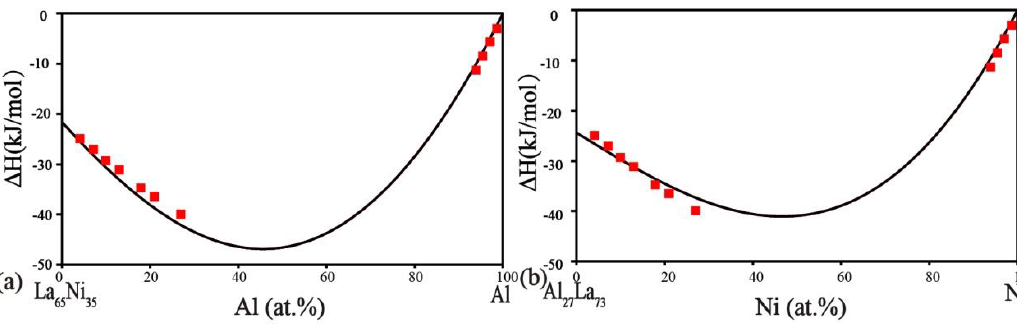
Figure 10. Calculated vertical section of Al 90 La – Al 90 Ni compared with the experimental data [42]. Materials 2018 , 11 , x FOR PEER REVIEW